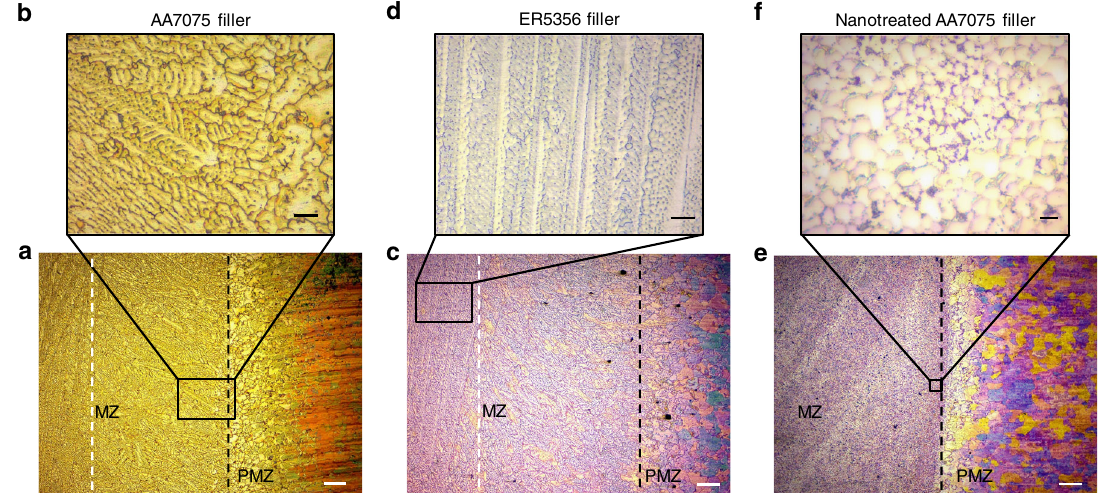
Fig. 2 Optical microscope characterization of horizontal weld bead cross-sections, in-plane with the welded base plates, as shown in Fig. 1. a , c and e Grain morphology of welds performed with AA7075, ER5356 and nano-treated AA7075 as fi ller material, respectively. The black dashed lines indicate the fusion line of melting zone (MZ) and partially melted zone (PMZ), while the white dashed lines indicate the transition of curved grain growth adjacent to the fusion line and columnar, trailing grain growth in the weld bead ’ s center. b Dendrite originated from fusion line. d Columnar grains in the weld ’ s center section. f Globular grains in MZ of nano-treated AA7075 weld. Scale bar, 200 µ m in a , c , e , 50 µ m in b , d , 10 µ m in